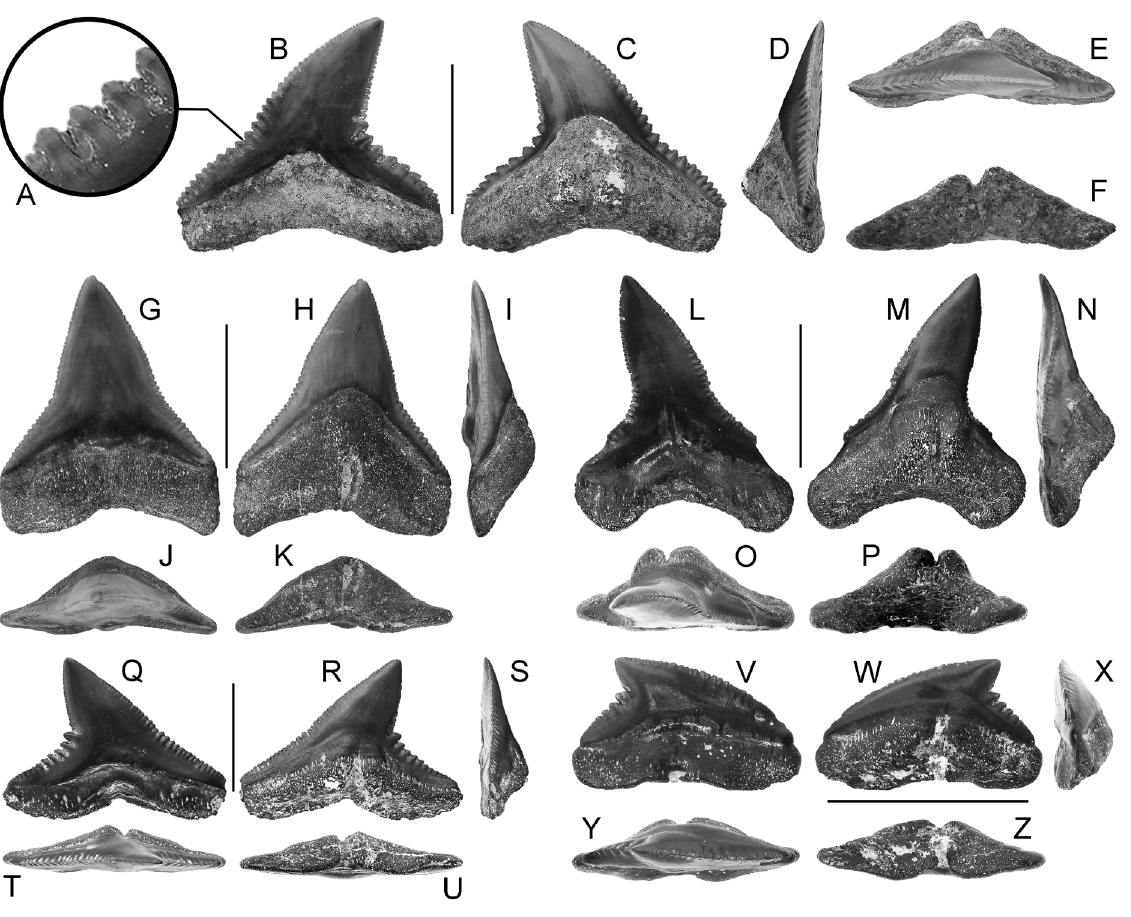
Fig. 25. Carcharhinus mancinae sp. nov. hypodigm. A–F . MSC 39036, holotype, upper right lateral tooth, basal Gosport Sand. A . Close–up of mesial compound serrations. B . Labial view. C . Lingual view. D . Mesial view. E . Oral view. F . Basal view. G–K . MSC 39037, paratype, upper left anterior tooth, basal Gosport Sand. G . Labial view. H . Lingual view. I . Mesial view. J . Oral view. K . Basal view. L–P . MSC 39040, paratype, lower right anterior tooth, basal Gosport Sand. L . Labial view. M . Lingual view. N . Mesial view. O . Oral view. P . Basal view. Q–U . MSC 39041, paratype, lower right lateral tooth, basal Gosport Sand. Q . Labial view. R . Lingual view. S . Mesial view. T . Oral view. U . Basal view. V–Z . MSC 39038, paratype, upper left posterior tooth, basal Gosport Sand. V . Labial view. W . Lingual view. X . Mesial view. Y . Oral view. Z . Basal view. Labial at bottom in oral and basal views. Scale bars = 1